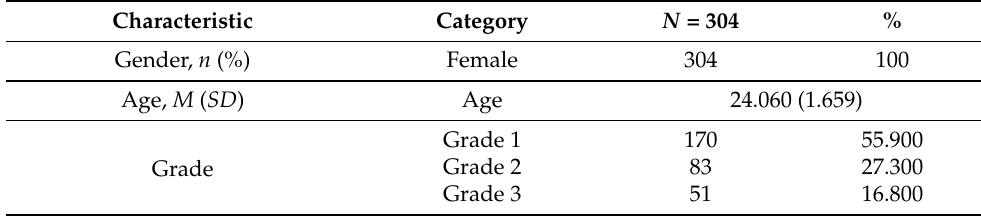
Table 1. Demographic characteristics of female